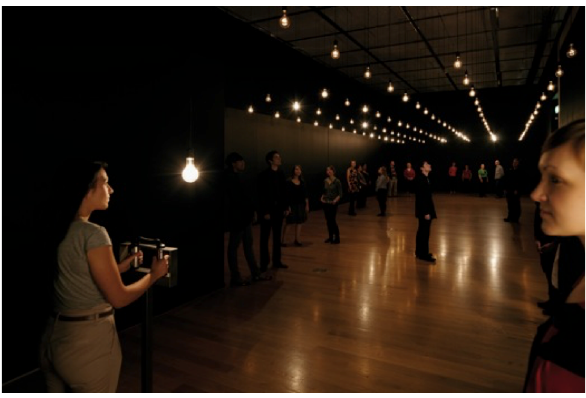
Figure 2 | Still from Macario (1960), directed by Roberto Gavaldón. Photography by Gabriel